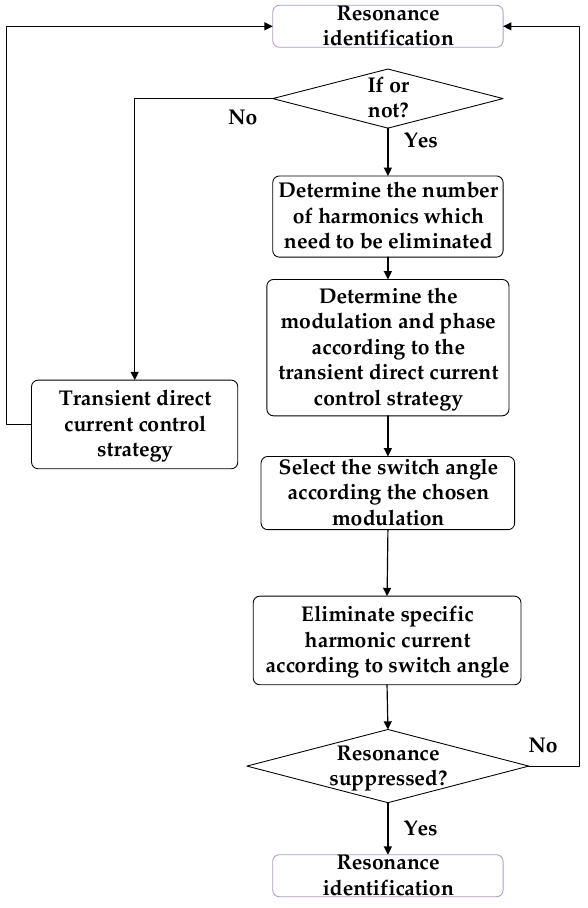
Figure 8. Flow chart of harmonic suppression.